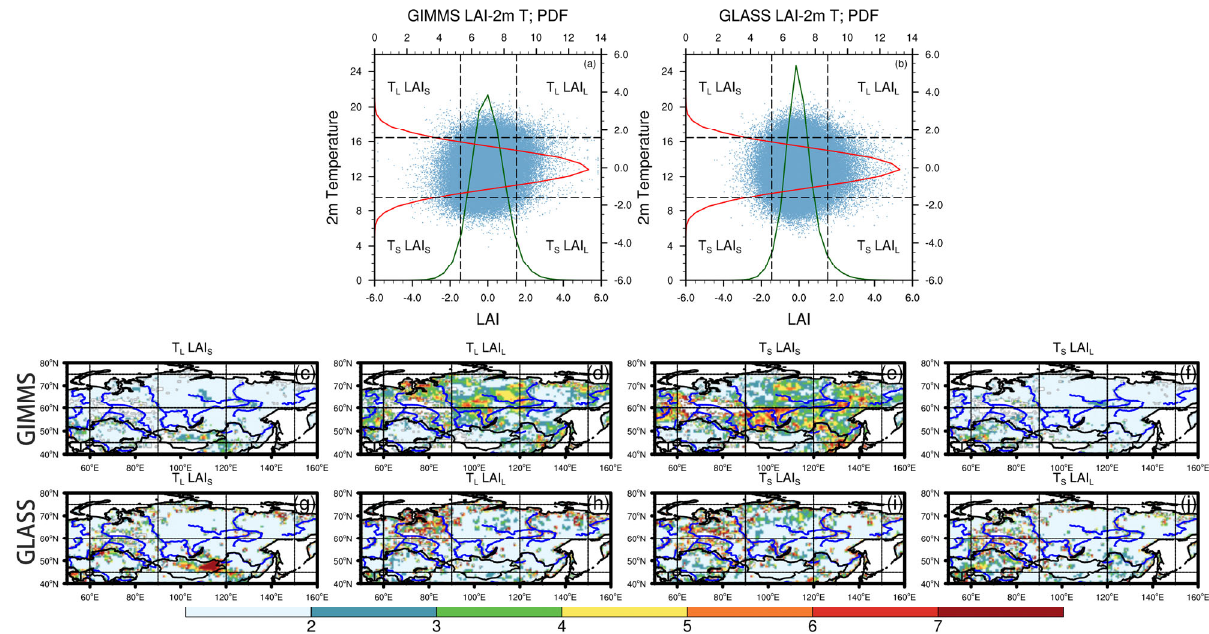
Figure 7. ( a , b ) Scatter plot of the 2 m temperature and LAI with their probability distributions overlaid (lines). The black dashed lines mark the of 5th and 95th percentiles. The subscripts “L” and “S” represent values of the variables larger than the 95th percentile and smaller than 5th percentile, respectively. ( c – j ) Frequencies of the 4-compound extreme LAI vs. extreme temperature